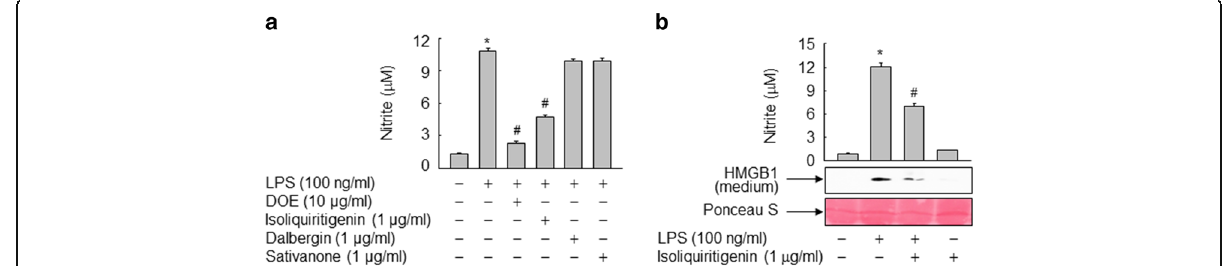
Fig. 7 Isoliquiritigenin inhibits LPS-induced NO formation and HMGB1 release in RAW264.7 cells. a Cells cultured for 24 h in serum-free medium were stimulated with vehicle (DMSO) or LPS in the presence of DOE, isoliquiritigenin, dalbergin, or sativanone. After incubation for 24 h, aliquots of conditioned media were subjected to nitrite analysis. b Cells cultured for 24 h in serum-free medium were triggered by vehicle (DMSO) or LPS in the absence or presence of isoliquiritigenin. After incubation for 24 h, equal volumes of conditioned medium were subjected to nitrite analysis or immunoblot analysis to determine the levels of HMGB1. Ponceau S staining was used as a loading control. The results are plotted as the means